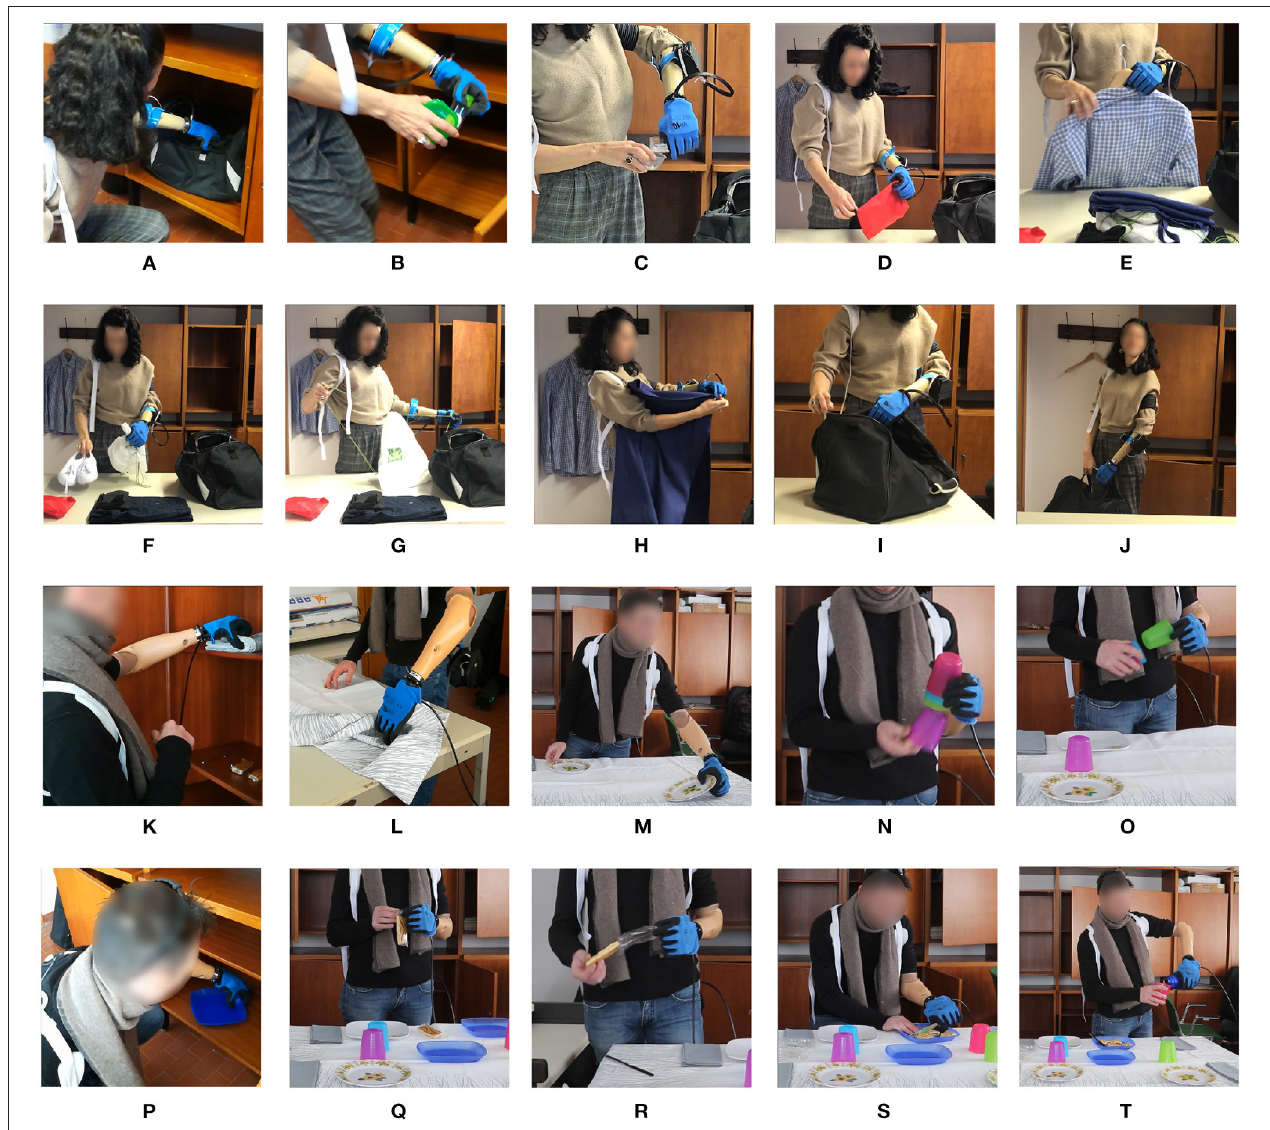
FIGURE 9 | (A–J) are still images of the various activities performed in the ACMC “packing” task, while (K–T) are taken from the ACMC “setting the table” task. The subject is using the Compact Configuration in the packing task and the Hardy Configuration in the setting the table